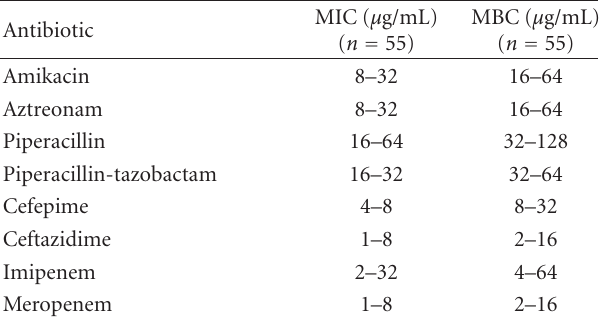
Table 1: Minimum inhibitory and bactericidal concentrations (MICs and MBCs) values of Pseudomonas aeruginosa strains.